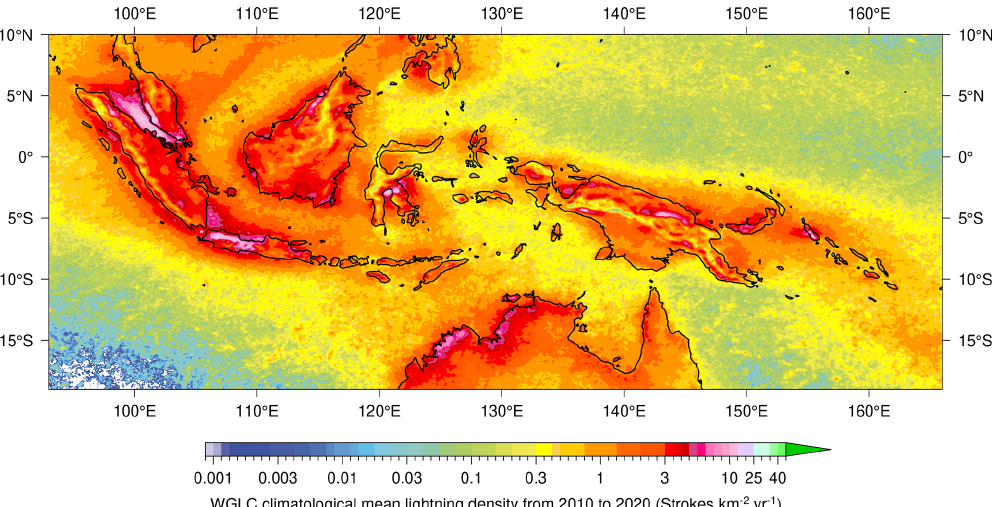
Figure 6. High-resolution (5arcmin) climatological mean annual lightning stroke density over equatorial southeast Asia and the western